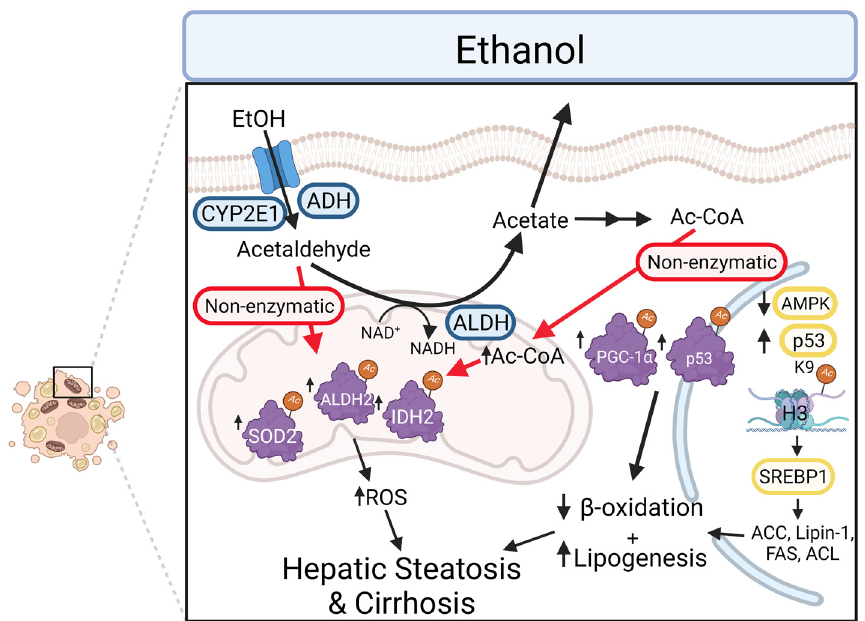
Figure 5. Alcohol metabolism by ADH, CYP2E1 and ALDH2 results in the generation of reactive metabolites acetaldehyde and acetate. The increased generation of acetaldehyde and Ac-CoA results in increased hepatic protein acetylation through non-enzymatic mechanisms. Increased acetylation affects specific proteins that are involved in mitochondrial health, such as SOD2, ALDH2, IDH2, PGC-1 𝛼 , and p53 [147,149] . Additionally, changes to transcription factors are observed with a decrease in AMPK (inhibiting autophagy) and increase in p53 (correlated with cell death), contributing to the development of cirrhosis [147] . The acetylation of histone H3 has been associated with SREBP1 and an increased expression of lipogenic proteins, contributing to hepatic steatosis [161,163] . Abbreviations: ACC, acetyl-CoA carboxylase; Ac-CoA, acetyl-CoA; ADH, alcohol dehydrogenase; ALDH2, aldehyde dehydrogenase 2; AMPK, adenosine monophosphate-activated protein kinase; CYP2E1, cytochrome P450 family 2 subfamily E member 1; FAS, fatty acid synthase; IDH2, isocitrate dehydrogenase